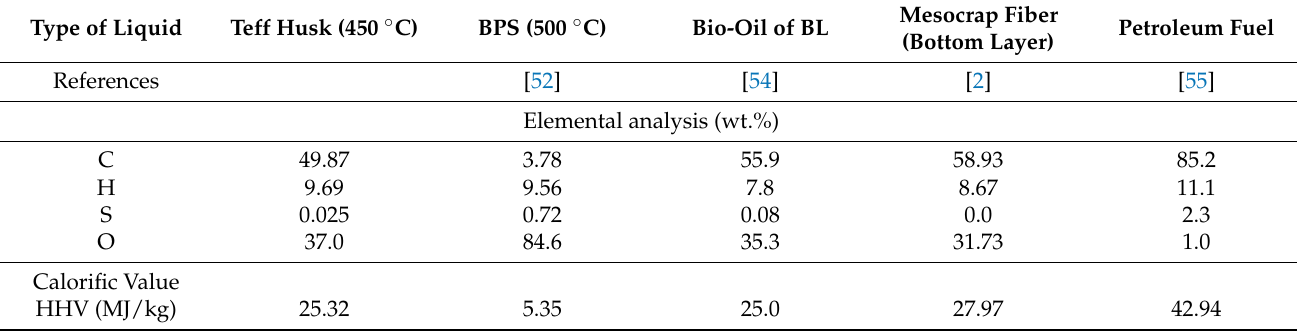
Table 4. Properties of teff husk bio-oil and comparison with petroleum fuel and other